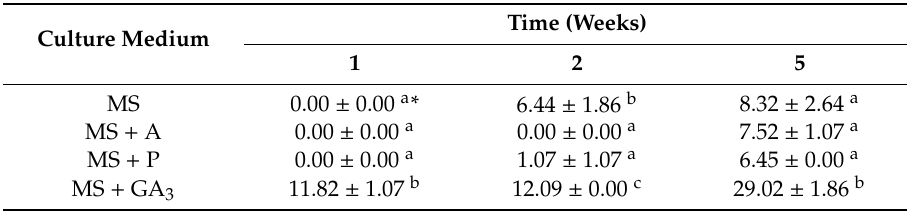
Table 3. Effect of GA 3 and GA inhibitors (10 μ M): ancymidol (A) and paclobutrazol (P) on bulb Table 3. E ff ect of GA 3 and GA inhibitors (10 µ M): ancymidol (A) and paclobutrazol (P) on bulb sprouting (%) cultured for 1, 2 and 5 weeks at 24 °C. sprouting (%) cultured for 1, 2 and 5 weeks at 24 ◦ C.